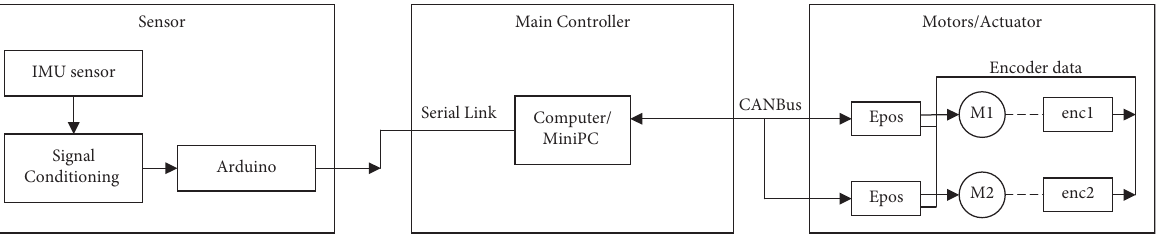
Figure 2: Electrical block diagram for the